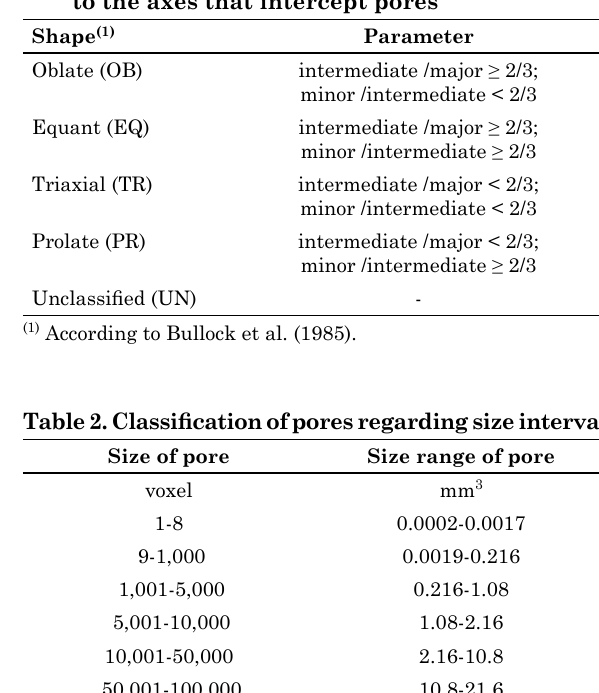
parameters. the terms a, b, and c represent the axes that intercept pores. adapted from bullock et al. (1985).